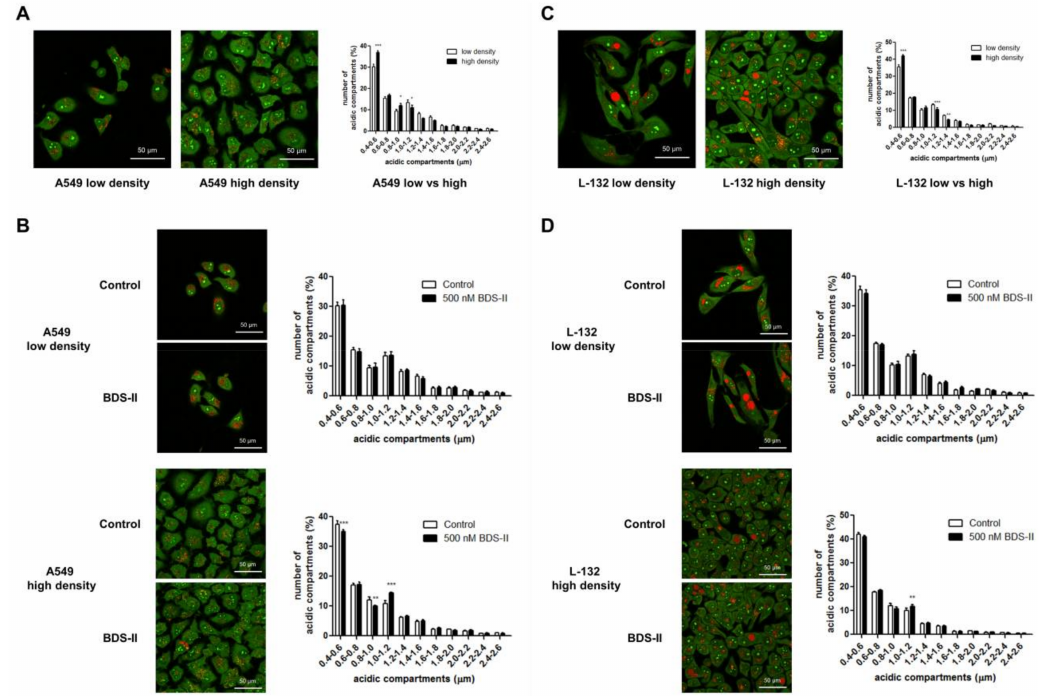
Figure 6. Acridine orange staining represents alterations in the diameter of acidic compartments in A549 and L-132 cells according to cell density. The orange-red fluorescence of acridine orange staining demonstrates the acidic compartments, including the intracellular organelles, and the yellow-green color indicates a slightly acidic or neutral pH. ( A ) The number of small (0.4–0.6 µ m) acidic compartments in A549 cells was significantly increased and the number of large (1–1.2 µ m) acidic compartments in A549 cells was decreased when the cells reached a high density compared to that of A549 cells at a low density. ( B ) When A549 cells were incubated with 500 nM BDS-II for 30 h, BDS-II had no effect on A549 cells cultured at a low density ( n = 13), whereas the same concentration of BDS-II decreased the number of small (0.4–0.6 and 0.8–1.0 µ m) acidic compartments and increased the number of large (1–1.2 µ m) acidic compartments in A549 cells cultured at a high density ( n = 17). ( C ) The number of small acidic compartments in L-132 cells was also significantly increased when the cells reached a high density compared with that of L-132 cells cultured at a low density. ( D ) L-132 cells were also incubated with 500 nM BDS-II for 30 h, and BDS-II had no effect on the size of the acidic compartments in L-132 cells cultured at either a low ( n = 13) or high density ( n = 17). All experiments were repeated the indicated number of times, and the data represent the mean ± standard error. * p < 0.05, ** p < 0.01, and *** p < 0.001 versus the control